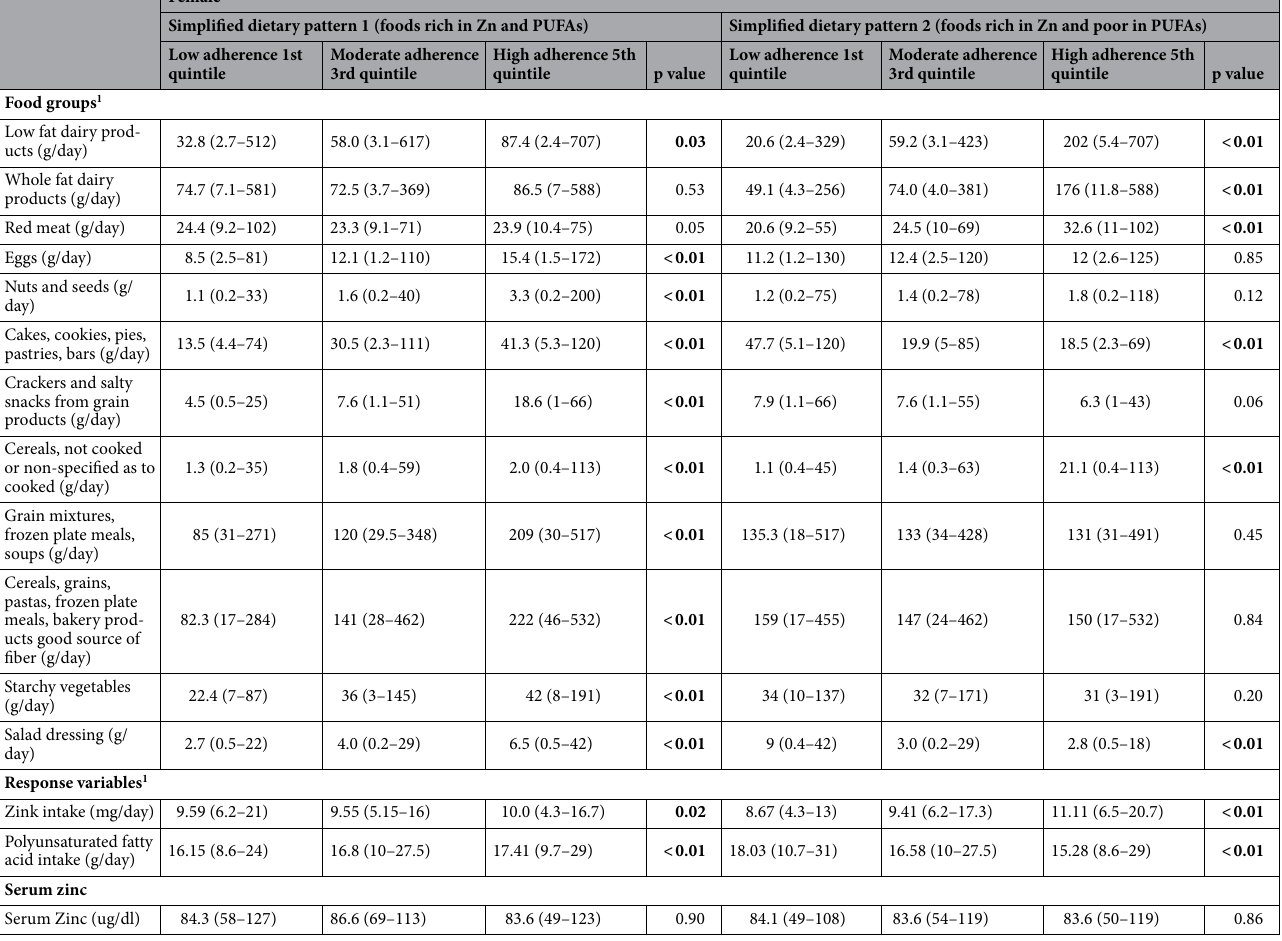
Table 3. Food groups, response variables intakes and serum Zn across quintiles of the simplified dietary pattern score. Female population NHANES 2011–2012. 1 Differences in quintiles for food and nutrients intakes were tested using linear trend, adjusting for energy. The top number in each cell is the median value and the data in parenthesis is the